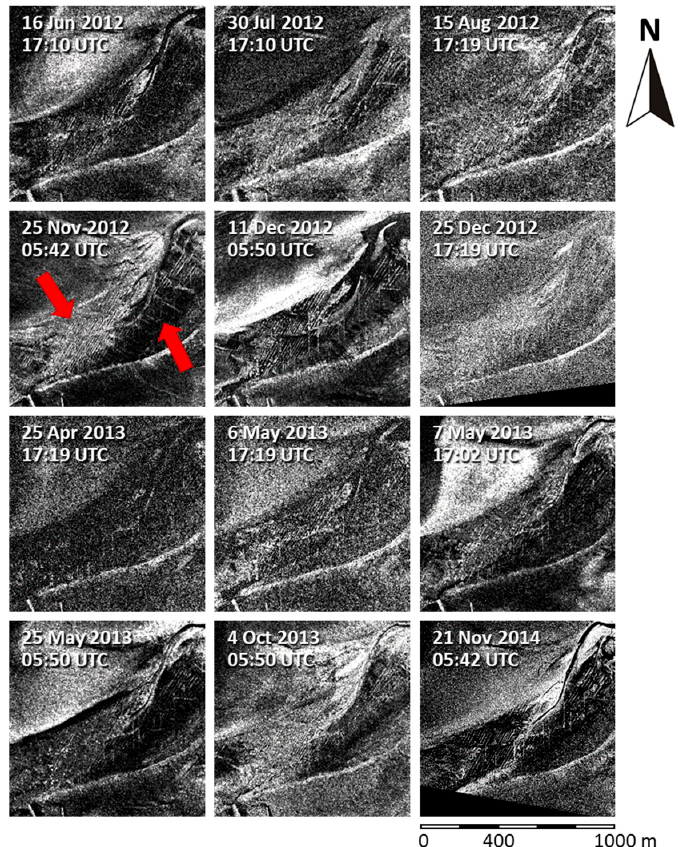
Figure 9. Examples of TerraSAR-X imagery of the area of interest marked by the left square in Figure 3. The red arrows mark several diagonal bright lines that can be identified on all SAR images, and that are due to traces of old drainage systems. They are best visible on the “staring spotlight” scene on the lower right. © DLR 2012, 2013, 2014.